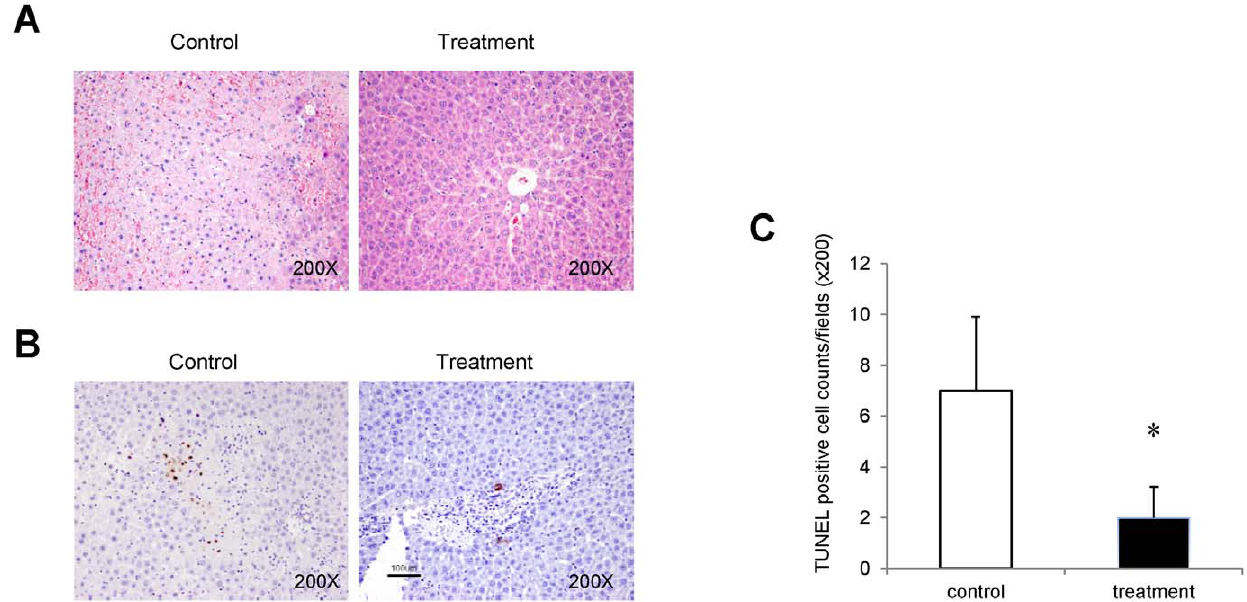
Figure 4. Hepatic architecture and apoptosis at 6 hours after hepatectomy and hepatic I/R injury. (A) Hepatic architecture was examined by H&E staining. (B) Hepatic apoptosis was detected by TUNEL staining. (C) Comparison of average apoptotic positive cells in 6 random fields (200 6 ). Each group contained 6 rats, * P , 0.05.